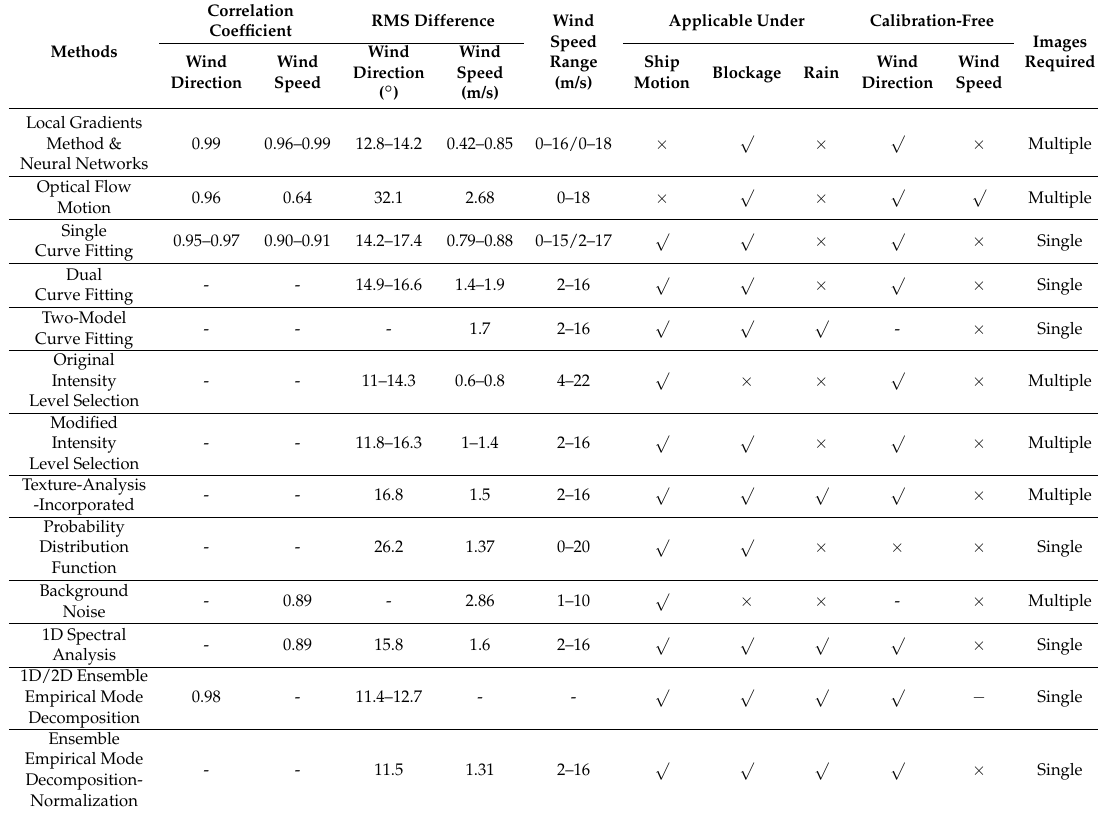
Table 1. Inter-Comparison of the Reviewed Wind Measurement